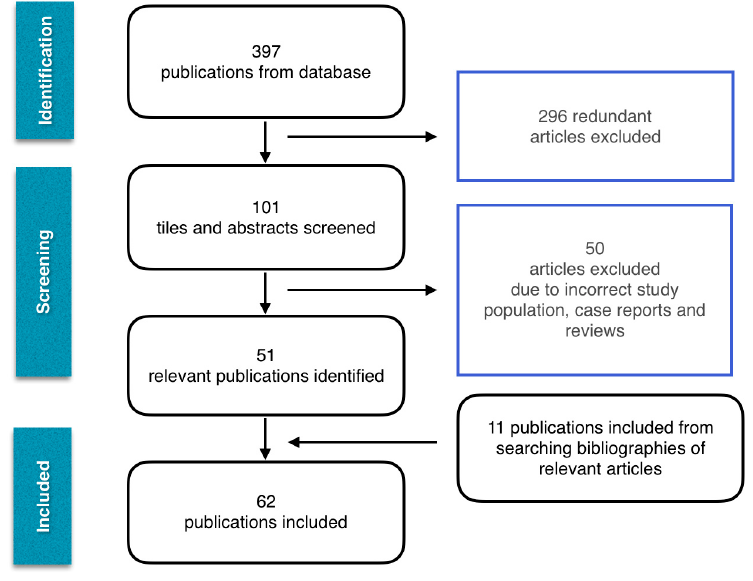
Figure 1. Flow diagram of studies included.